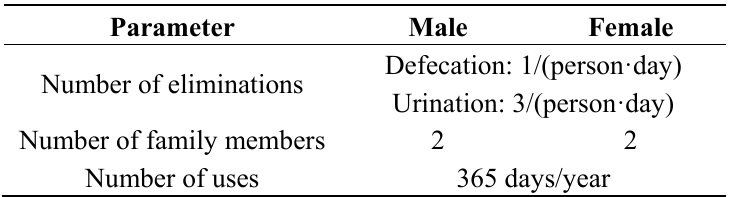
Table 1. Use stage calculation model for toilet bowls in